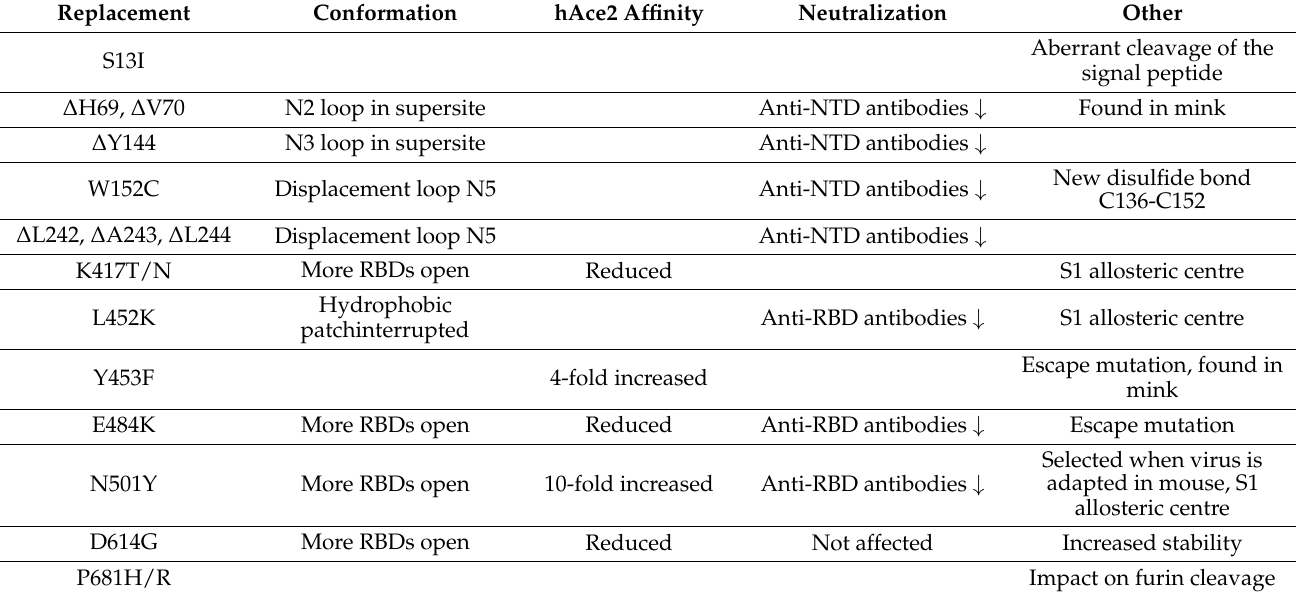
Table 2. Consequences of the amino acid